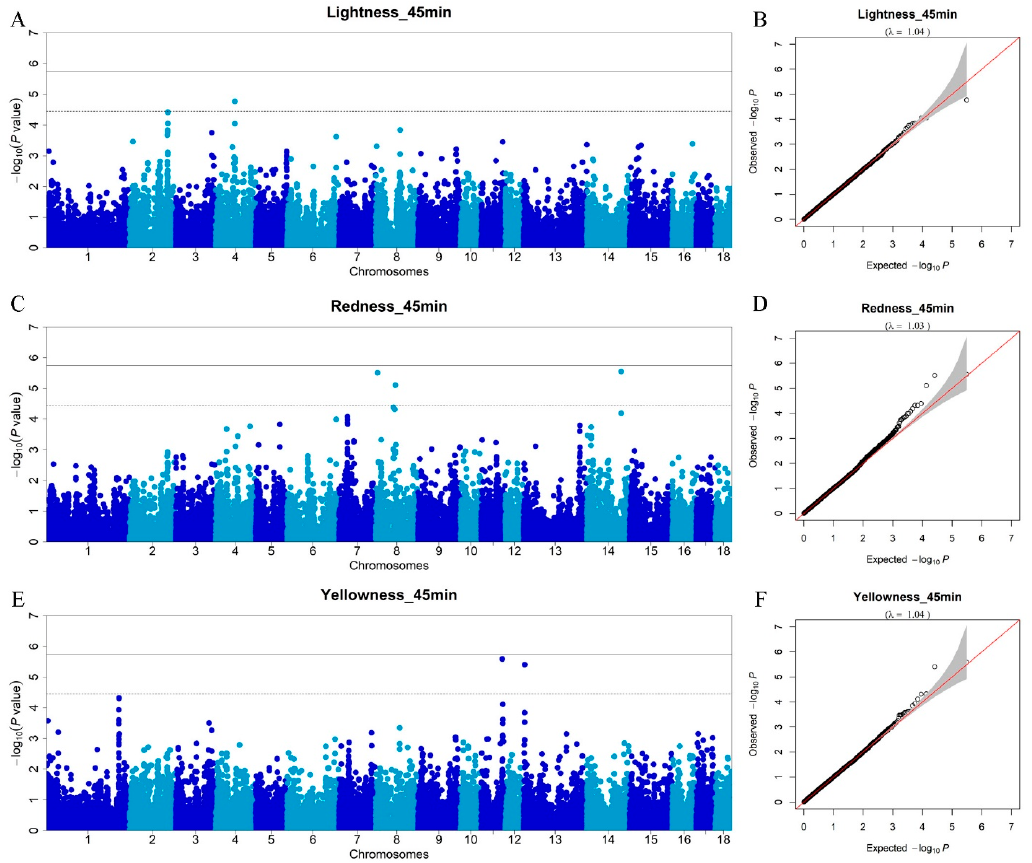
Figure 3. Manhattan plots of the GWAS and Q–Q plots for meat color traits (45 min). ( A ) GWAS for L* _45min (lightness_45min); ( B ) Q–Q plot for L* _45min (lightness_45min); ( C ) GWAS for a* _45min (redness_45min); ( D ) Q–Q plot for a* _45min (redness_45min); ( E ) GWAS for b* _45min (yellowness_45min); ( F ) Q–Q plot for b* _45min (yellowness_45min). The x -axis represents the chromosomes, and the y -axis represents the − log10 ( p -value).